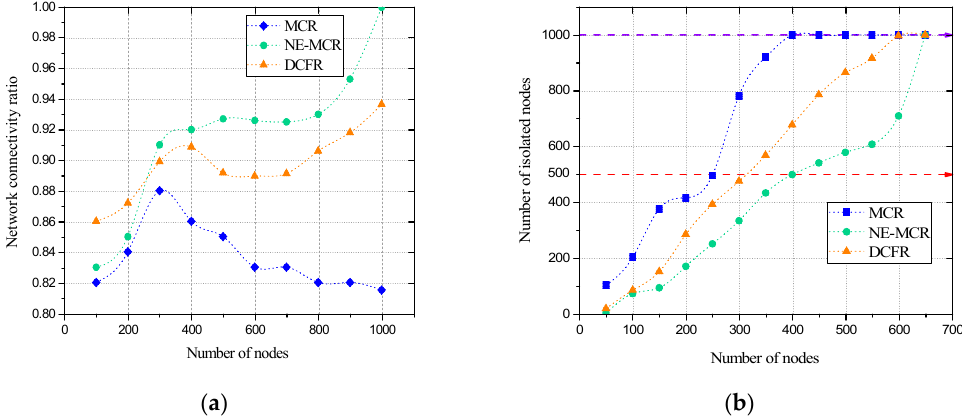
Figure 11. Simulation results regarding: ( a ) network connectivity ratio; ( b ) network isolation rate.